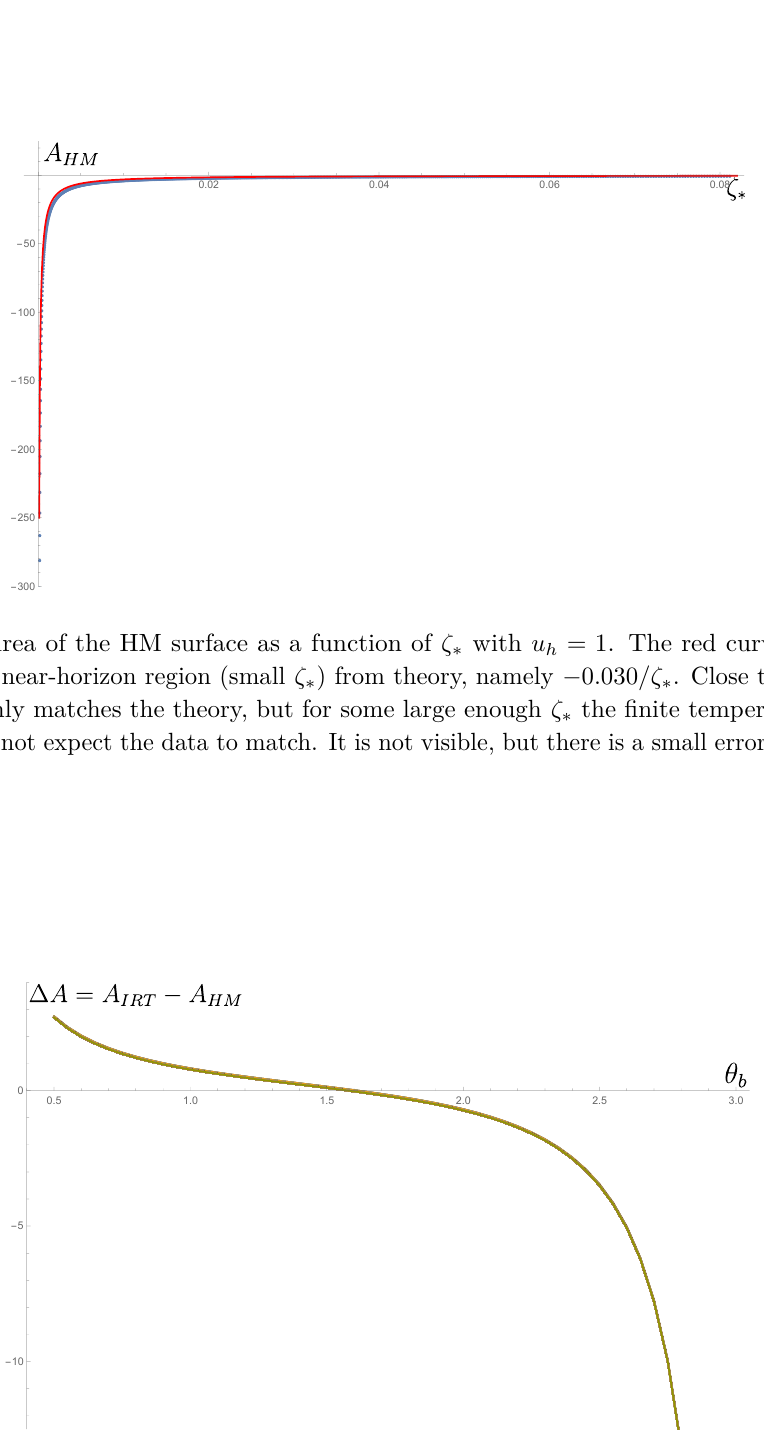
Figure 17 . Area difference as a function of brane angle, for Γ = 0 . 32 for angular cutoffs ranging from 0.0005 to 0.2 in steps of 0.0005 (with u = 1 ). Each curve is shown in a different colour, but h since they are very close it is hard to distinguish one from the